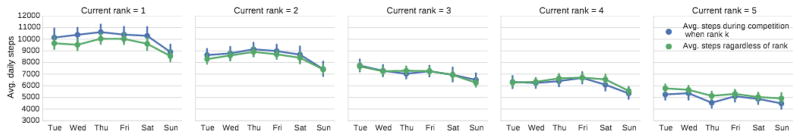
Average number of steps taken by users with specific current ranks in the competition over different days of the week for 7-day competitions with 5 participants.